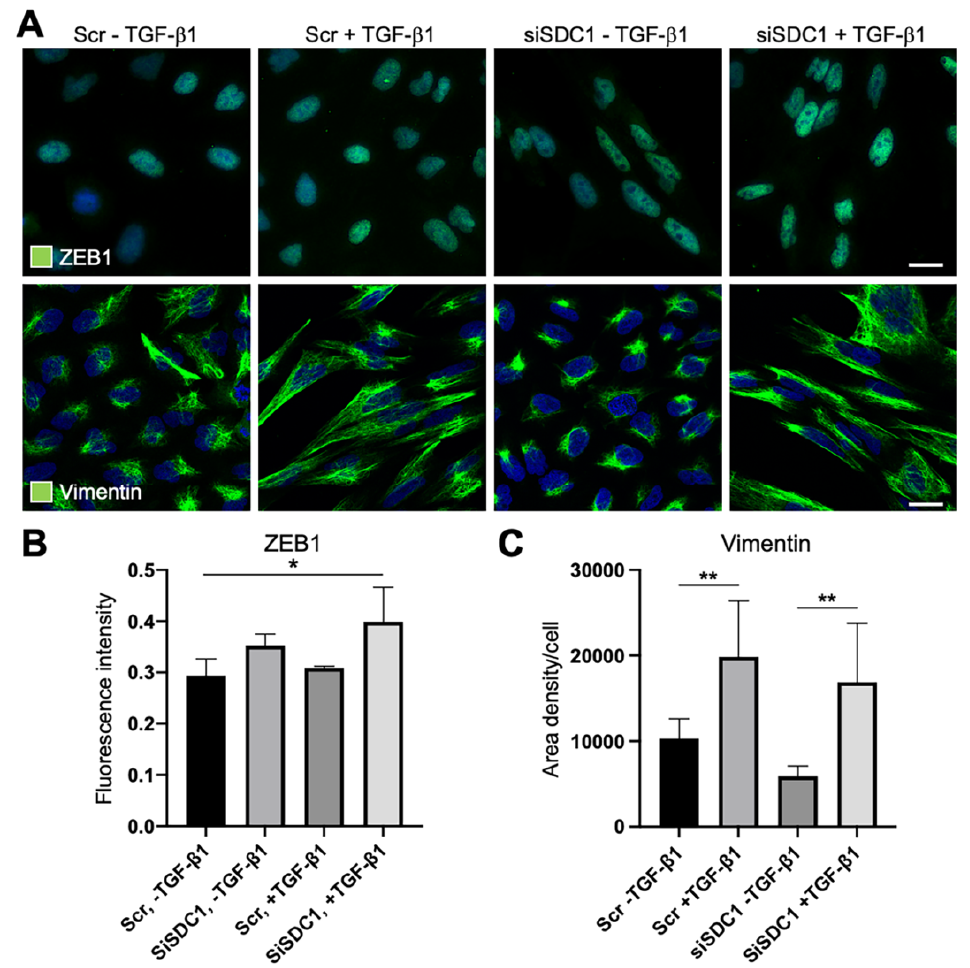
Figure 4. Immunofluorescence analysis of the effect of SDC1 knockdown on TGF-β1-induced EMT in A549 cells. ( A ) Immunofluorescence images showing staining of ZEB1 and vimentin in A549 cells transfected with scrambled control siRNA (Scr) or SDC1 siRNA (siSDC1), and thereafter left untreated or treated with TGF-β1 (10 ng/mL, 48 h). Cell nuclei were counterstained with DAPI (blue). Scale bars = 5 µm. ( B , C ) Bar graphs showing results from image-based analysis and quantification of the effect of SDC1 knockdown and TGF-β1 exposure on the intensity of ZEB1 staining ( B ) and area density of vimentin ( C ). * = p < 0.05; ** = p < 0.01.